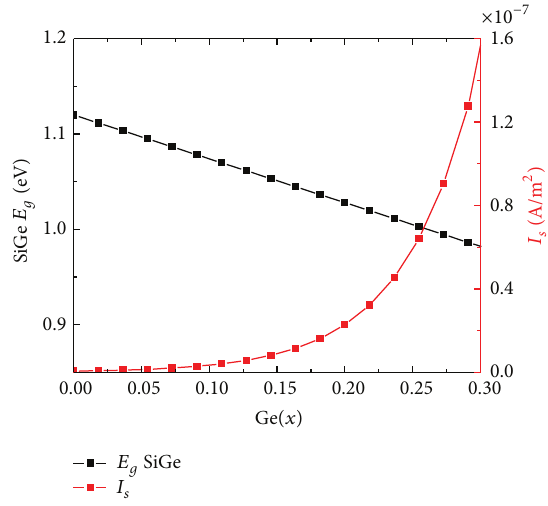
Figure 8: SiGe bandgap and saturation current